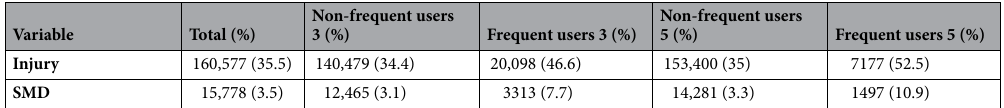
Table 1. Descriptive statistics for the different populations. Percentages in brackets are relative to the column. PPDIP public prescription drug insurance plan, GIS ≥ 65 years with guaranteed income supplement, LRFA recipients of last resort financial assistance, COPD chronic obstructive pulmonary disease, CHF congestive heart failure, CAD coronary artery disease, HBP high blood pressure, CNCP chronic non-cancer pain, CMD common mental disorders, SMD serious mental disorders.